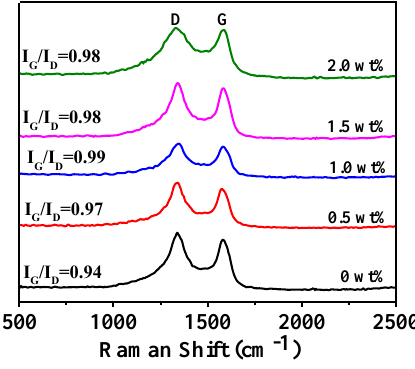
Figure 4. Raman spectra of HGCS whose XRD patterns are given in Figure 3.